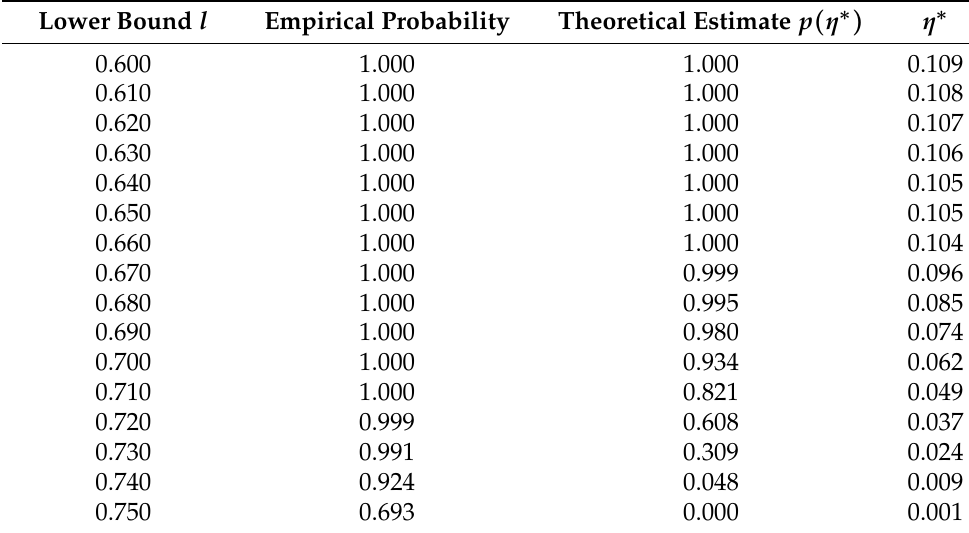
Table 4. Simulation results for B(0.1, 10), number genes = 20,000, proportion significant = 0.1, real power limit =